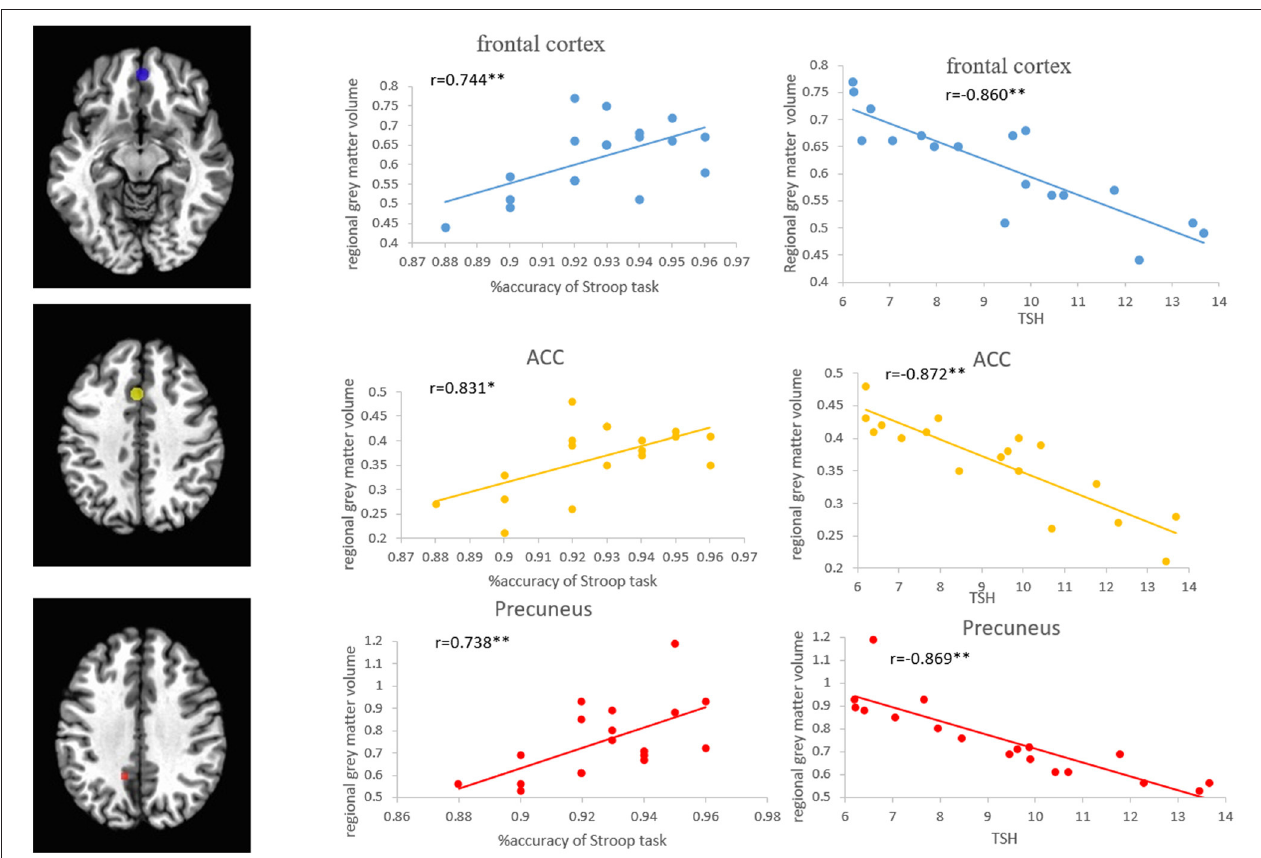
FIGURE 6 | Correlations between the regional GMVs of the frontal cortex, ACC, and precuneus, and the Stroop task and TSH level in patients with SCH. ACC, anterior cingulate cortex; SCH, subclinical hypothyroidism; TSH, thyroid-stimulating hormone.